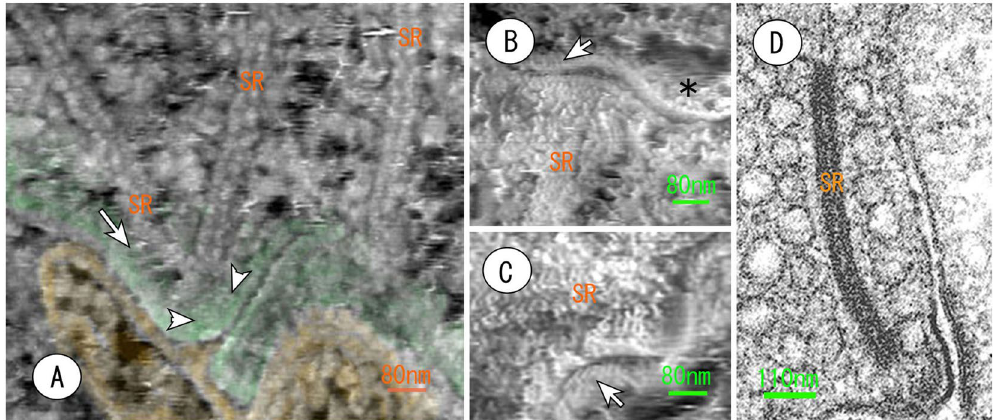
Figure 4. Atomic force micrographs of the synaptic active zone of photoreceptor cells ( A , B , C ). ( A ) The synaptic ribbons (SR) are tethered onto the cytoplasmic surface (green) of the pre-synaptic cell membrane with short filaments (arrow). The arrowheads indicate the characteristic circular structure on the cytoplasmic surface. ( B ) The post-synaptic membrane facing the pre-synaptic active zone contains several trans-membrane particles (arrow). An asterisk shows the cytoplasmic surface of the post-synaptic membrane. SR: synaptic ribbon. ( C ) The external surface of the post-synaptic membrane facing the active zone contains highly ordered particles (arrow). ( D ) A conventional thin section EM image in the synaptic active zone is provided in the inset for comparison. SR: synaptic